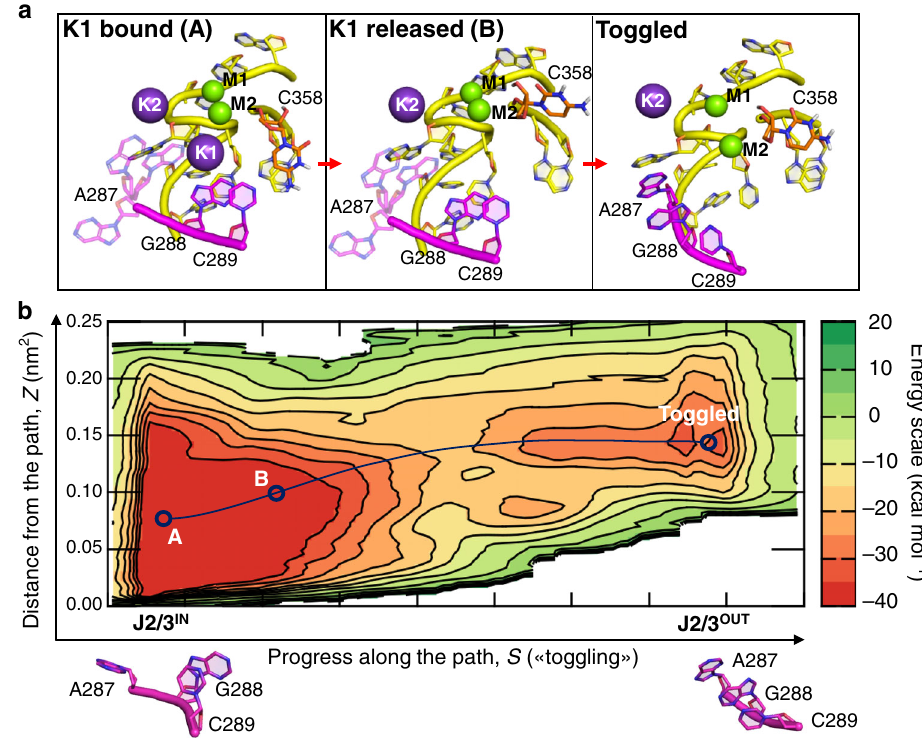
Fig. 6 Energetics associated with intron toggling in the protonated state. a Structural architecture of the active site for the intermediate A, intermediate B, and toggled states identi fi ed by the MtD simulation reported in ( b ). b Path MtD free energy landscape of the cleaved-H + state. The intermediate A, intermediate B, and toggled states are indicated along the MtD trajectory (dark blue dotted line). The energy scale is indicated in kcal mol − 1 on the right. The conformations of the J2/3 junction in state A and in the toggled state are represented at the bottom of the fi